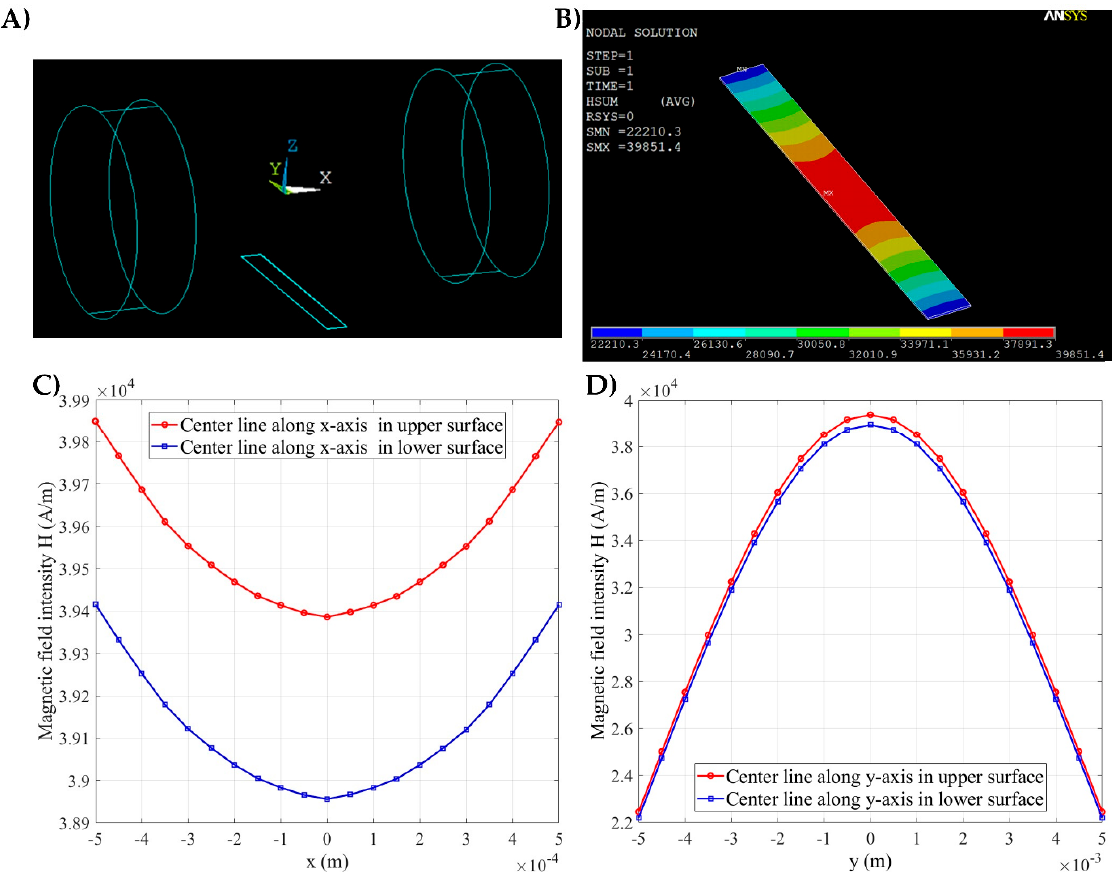
Figure 4. The ANSYS Emag software for the simulation of the magnetic field in the proposed system. ( A ) Model of permanent magnet and microfluidic channel. ( B ) Simulation of the magnetic field intensity distribution in the microfluidic channel. ( C ) Magnetic field intensity values on the centerline of the upper and lower surfaces of the flow channel along the x -axis. ( D ) Magnetic field intensity values on the centerline of the upper and lower surfaces of the flow channel along the y